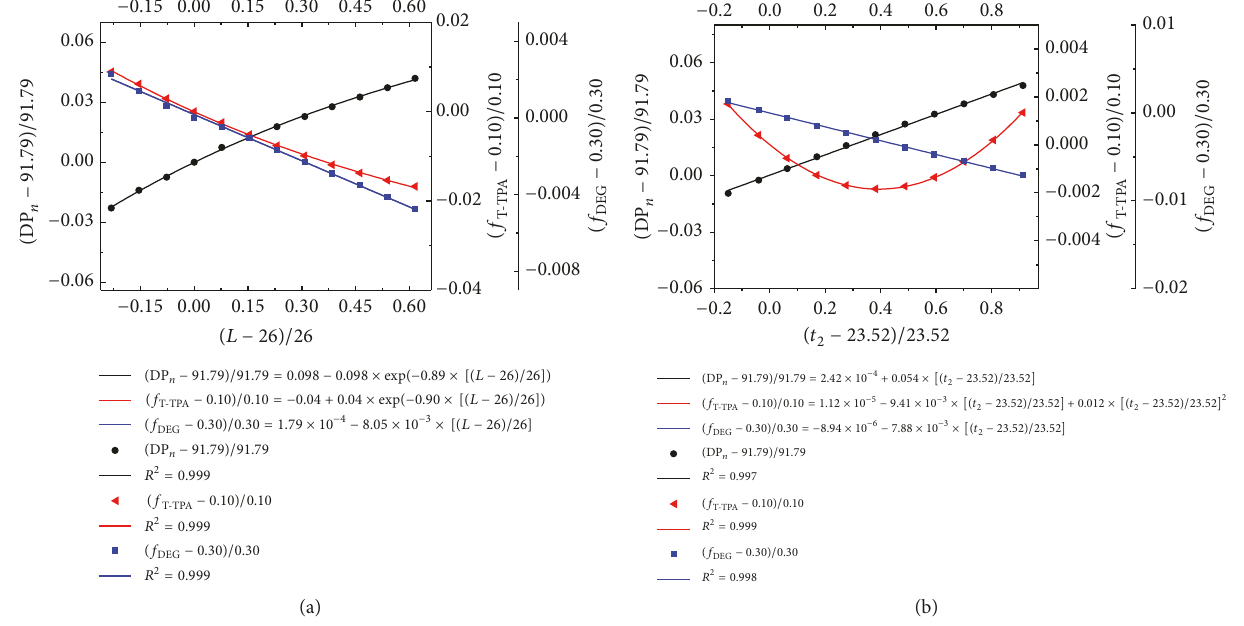
Figure 7: Effects of (a) number of layers in the falling film reactor and (b) residence time in the rotating disk reactor on quality indexes of liquid polymerization product.